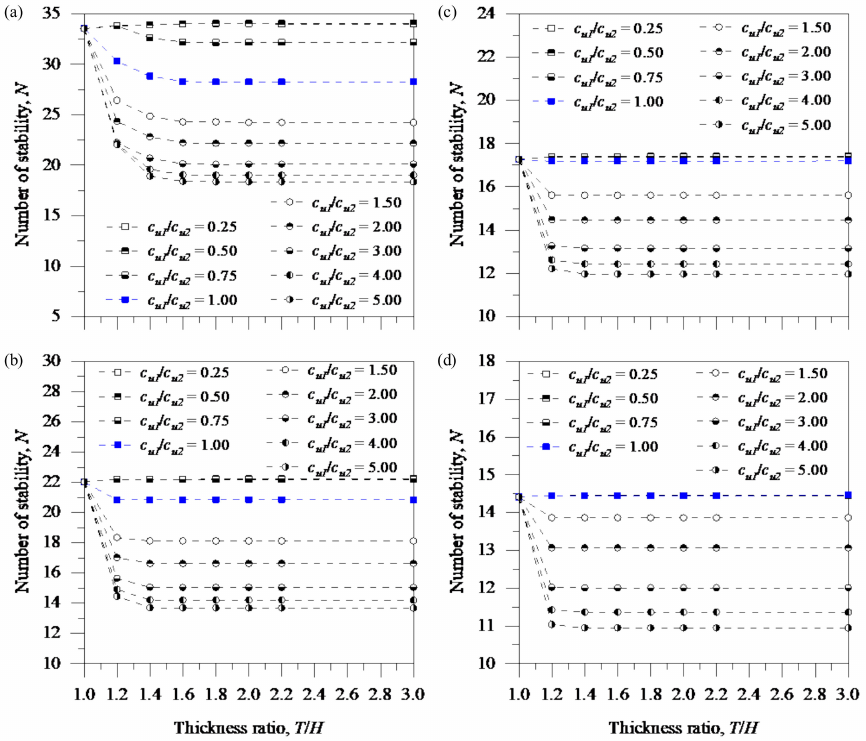
Figure 11. The e ff ect of thickness of the soil layer to the rigid body at a toe of slope, where D / H = 1, H / B = 0.5, ( a ) β = 15 ◦ , ( b ) β = 30 ◦ , ( c ) β = 45 ◦ , and ( d ) β = 60 ◦